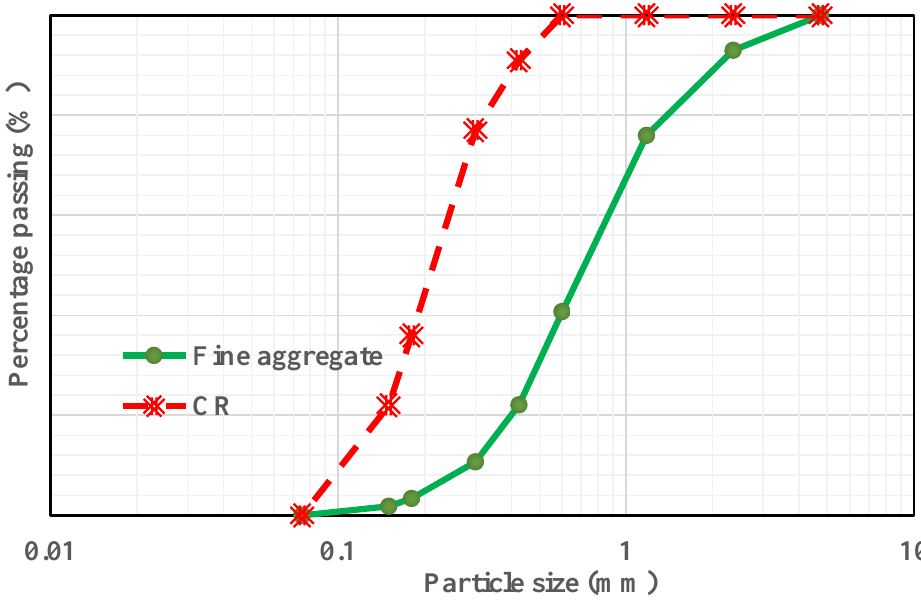
Table 4. Physical properties of fine aggregates.